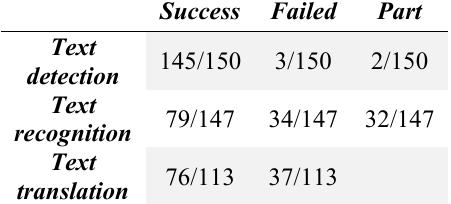
Figure 8. below is showing the testing results using random dataset. The number of success, failure and partly detected, recognized and translated images are shown in the Table